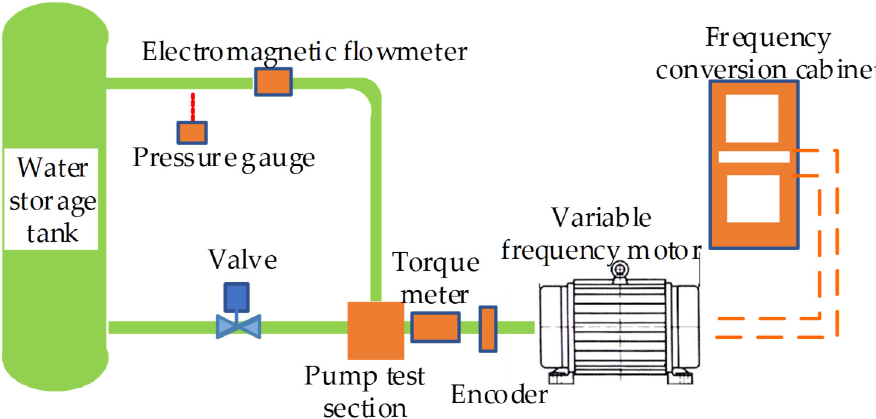
Figure 2. Closed test bench system of a high-speed inducer centrifugal pump.